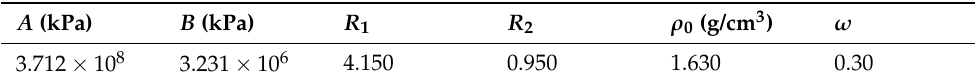
Table 1. JWL parameters for